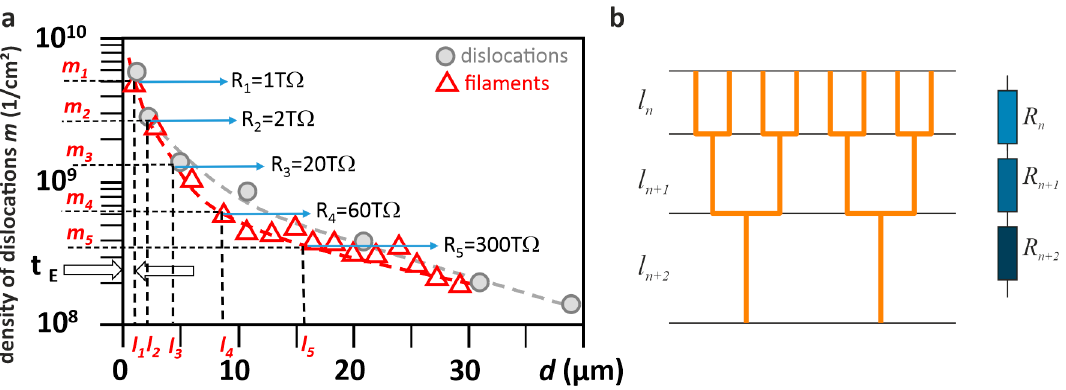
Figure 7. Analysis of the conducting filaments formed along a network of dislocations in SrTiO 3 . ( a ) Density of dislocations obtained from TEM investigations by Wang et al. [36] in combination with the density of conducting filaments obtained by an LC-AFM analysis by Szot et al. [14]; ( b ) Illustration of the model of the hierarchical tree of filaments.